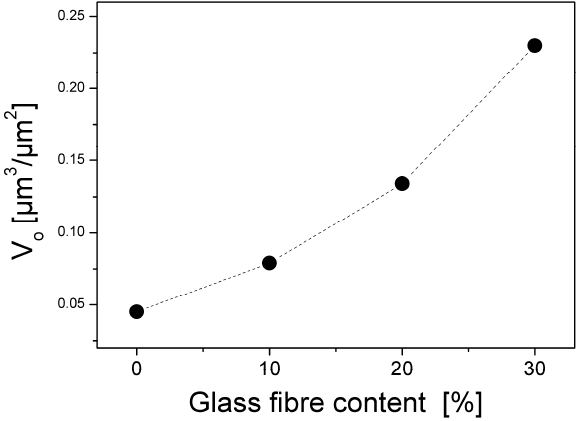
Figure 16. Effect of glass fibre content on porosity. Before calculation of Porosity (V short waviness was filtrated (removed). The values of Porosity in this graphic are not influenced by short waviness.